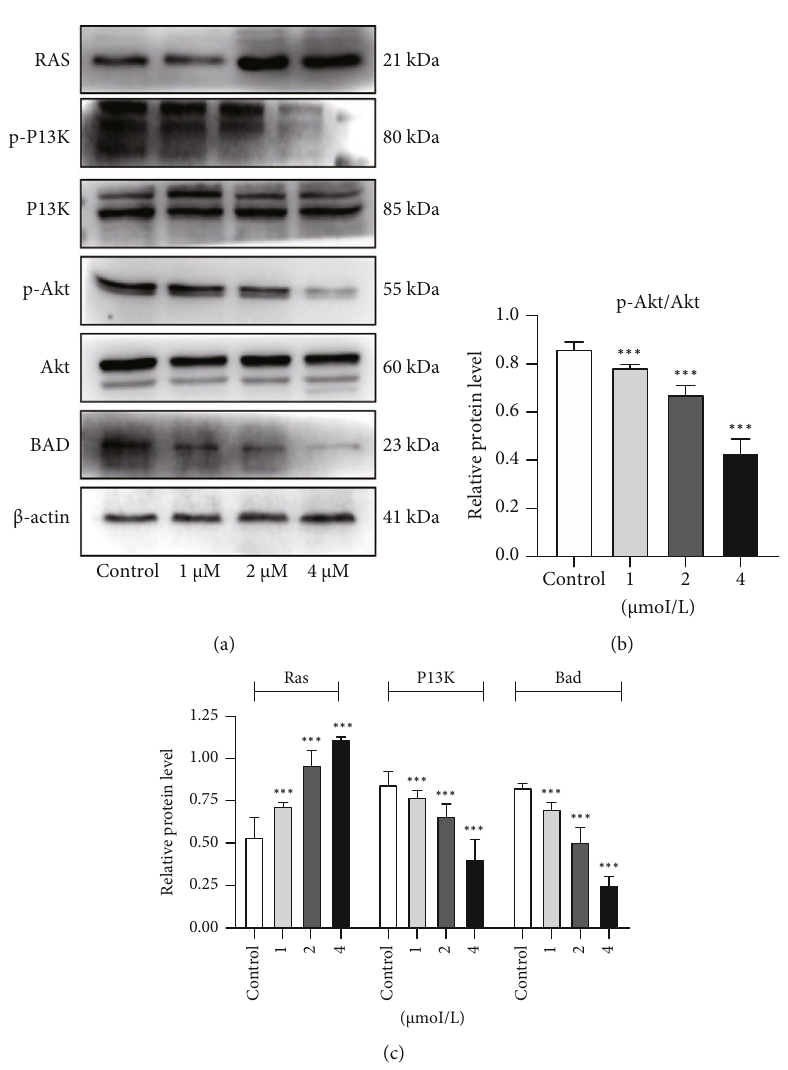
Figure 6: E ff ect of anlotinib on the RAS and PI3K/Akt signalling pathways in HSC-3 cells. HSC-3 cells were treated with anlotinib for 72 hours. Total RAS, phosphorylated and total Akt, and β -actin were detected by western blotting. (a) Molecular mechanism of anlotinib in HSC-3 cell apoptosis. (b) Changes in the p-Akt/Akt ratio in apoptosis. (c) Ratio changes of RAS, PI3K, and Bad proteins in apoptosis based on quantitative results of protein expression. The data are expressed as the mean ± standard deviation of three repeats. ∗∗∗ P < 0 : 001 compared with the control.